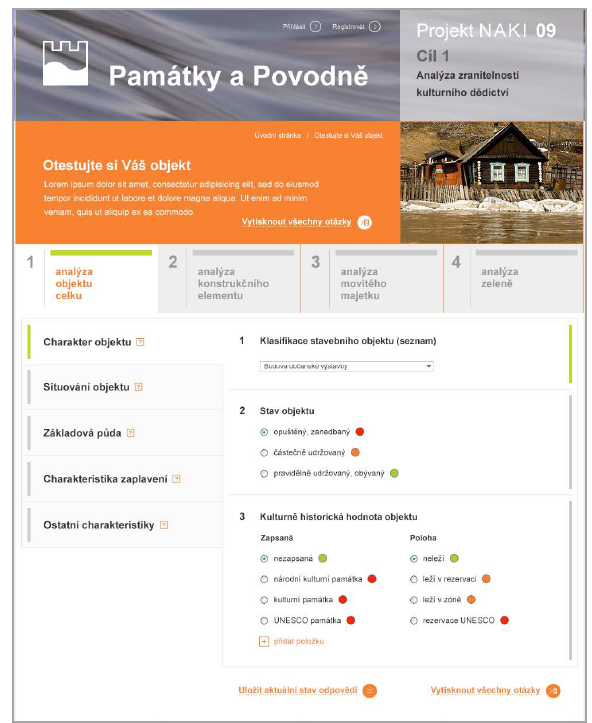
Design of the users’ web